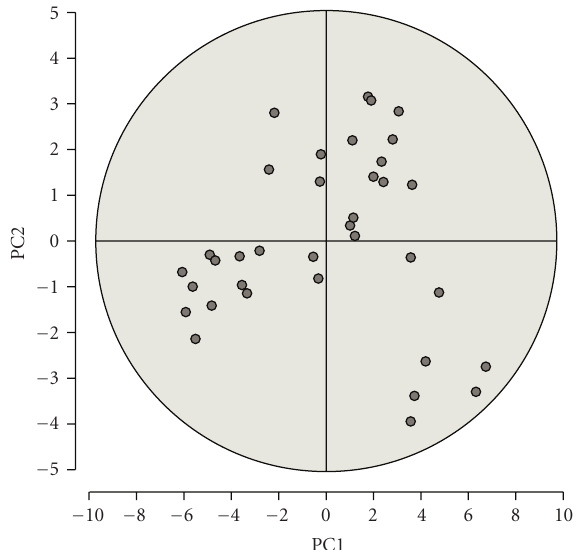
Figure 3: Principal component analysis of the 36 spot maps, representing the 36 samples originating of 6 volunteers. No outlying spot maps could be identified.